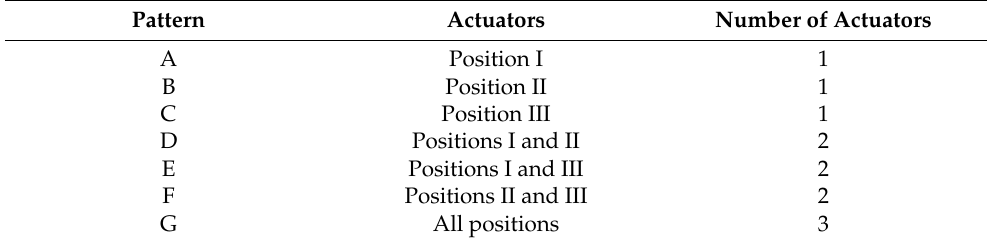
Table 2. The seven experimental